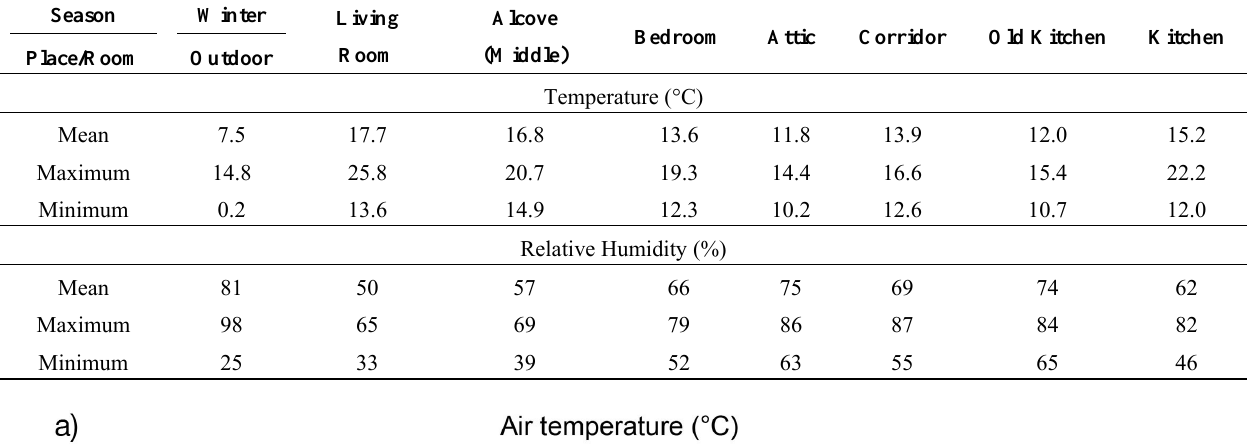
Table 4. Comparison of outdoor and indoor air temperature and relative humidity values in case study 2 during the winter season.